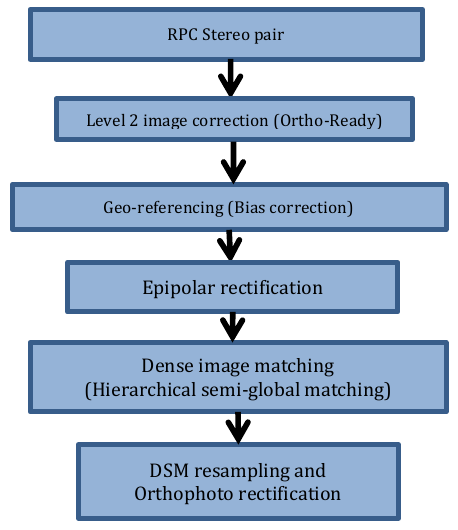
Figure 1. A processing chain used for